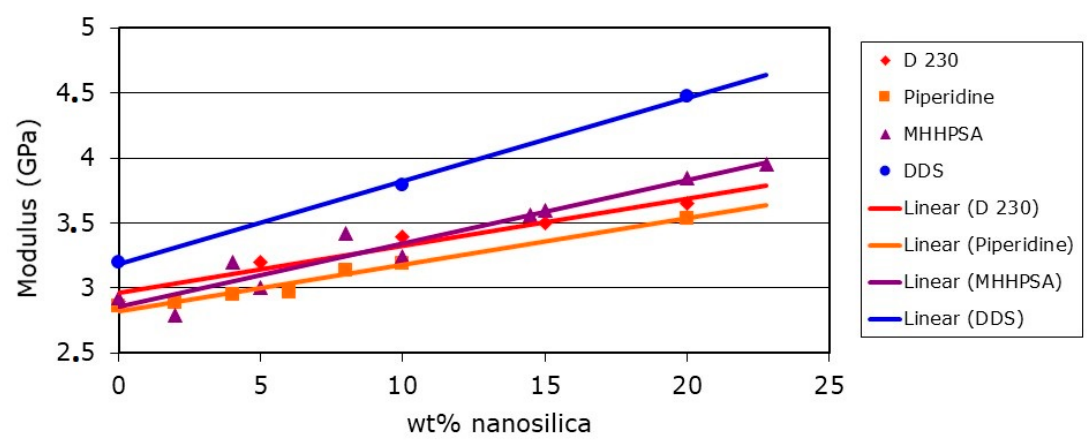
Figure 5. DGEBA epoxy resin modulus as a function of silica nanoparticle content for different curing agents [13].